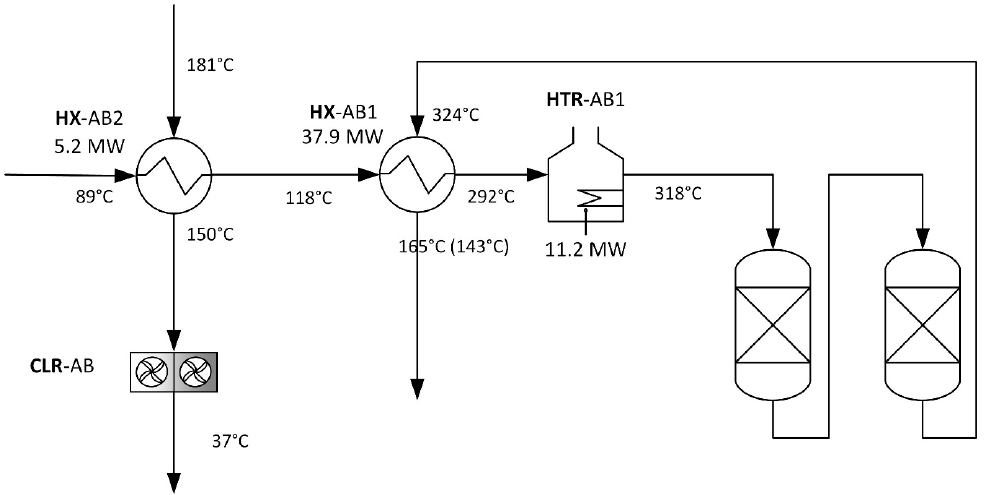
Figure A4. Retrofit proposal 1C.